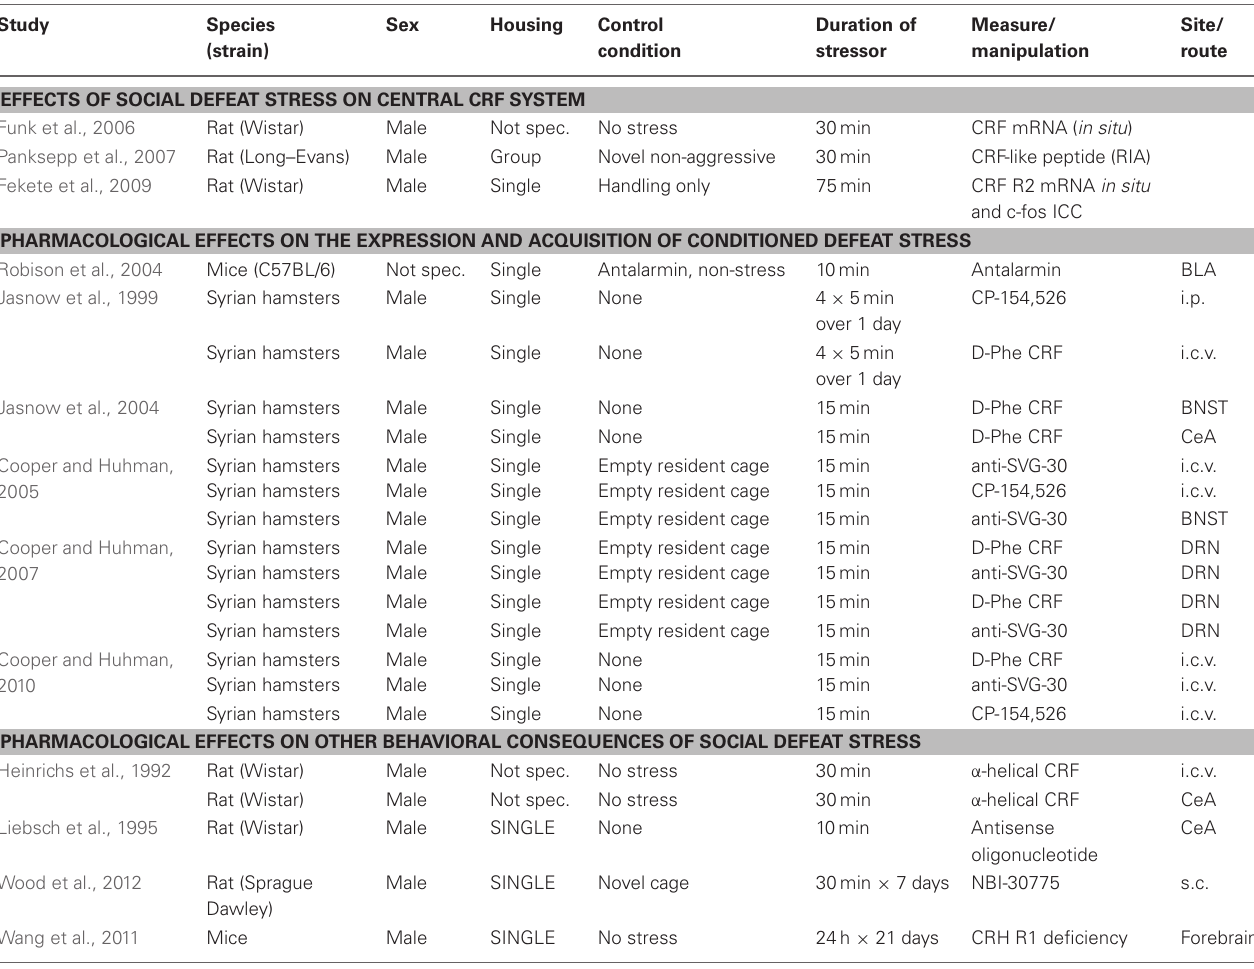
Table 1 | Experimental conditions for studies on the role of the CRF system in social defeat stress. Study Housing Control